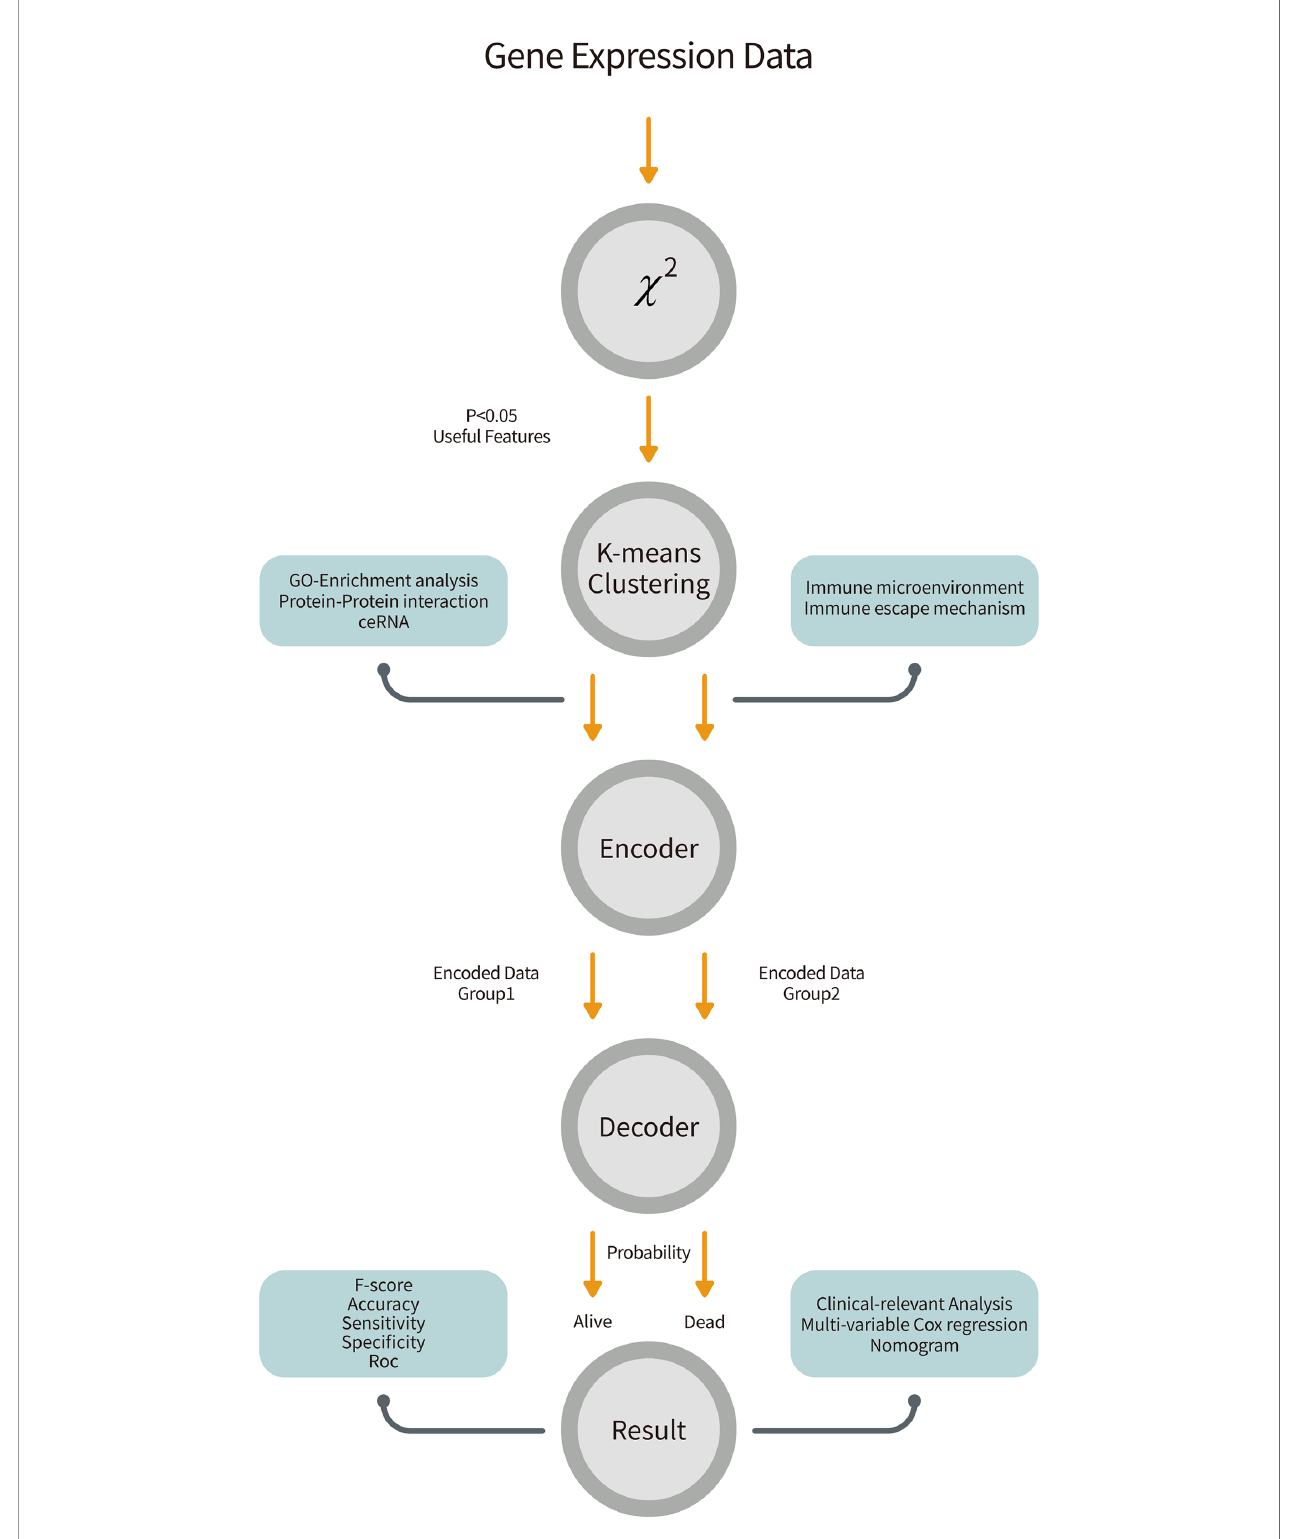
FIGURE 1 | The overall work fl ow of our pipeline. Gene expression data from GSE49710 was retrieved and performed a chi-square test to fi lter 172 features. The K- means clustering method partitioned patients and genes into two groups. We trained two neural networks for two groups of features and combined them by the attention mechanism to predict survivals. Further, we analyzed biological effects between two groups and did clinical-relevant analysis.